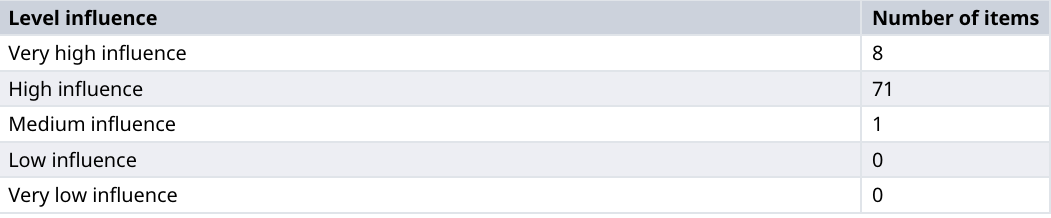
Table 6. Level influence based on number of items.